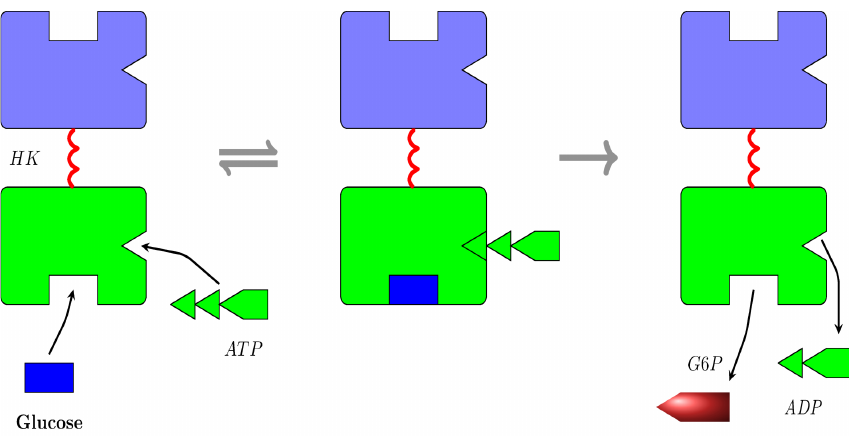
Figure 5. The mechanism for the phosphorylation of glucose by hexokinase I